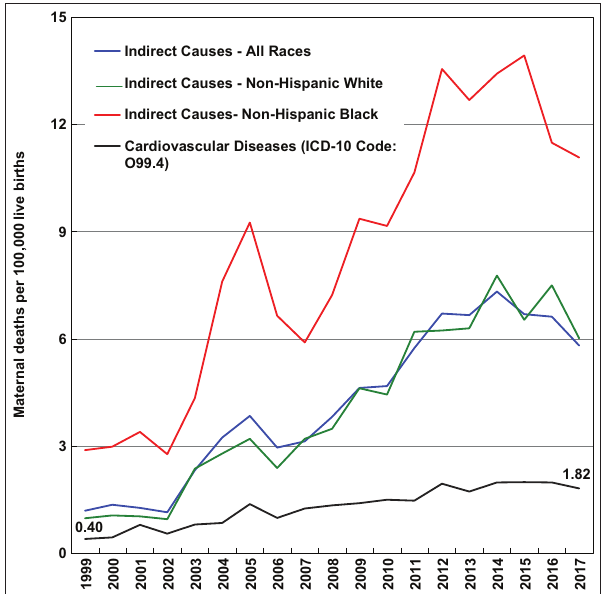
Figure 1: Trends in maternal mortality from indirect obstetric causes (ICD-10 Codes: O98-O99), United States, 1999-2017 Source: Data derived from the National Vital Statistics System. Table 1: Maternal deaths and mortality rates per 100,000 live births due to specific indirect obstetric causes, (ICD-10 codes: O98-O99), United States, 1999-2017 (number of live births =76,972,334) Cause of death (ICD-10 codes) Maternal Maternal Deaths Mortality Rate